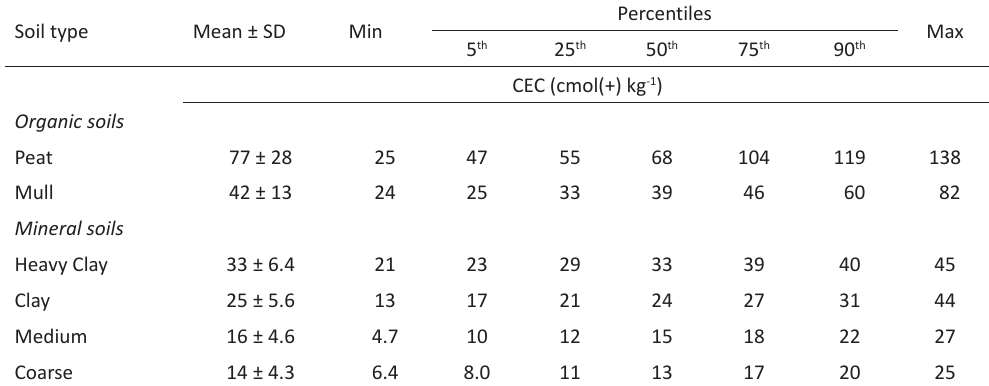
Table 4. General statistics for potential cation exchange capacity (CEC, cmol(+) kg -1 ) in different soil types (see number of soil samples (n) in Table 2 and